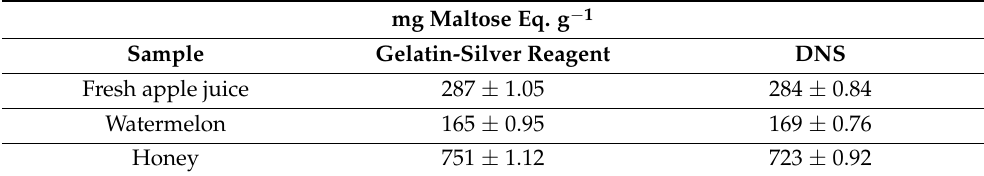
Table 2. Total reducing sugar content (as mg maltose Eq. g − 1 ) of studied samples. Each point represents the mean of three experiments ±